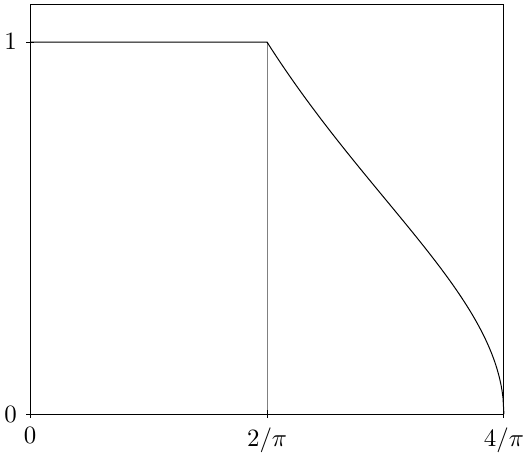
Figure 7 . The probability density function for the normalized spectrum is 1 on [0 , 2 /π ] and x 7→ x − 1 / 2 (4 /π − x ) 1 / 2 on [2 /π, 4 /π ] .